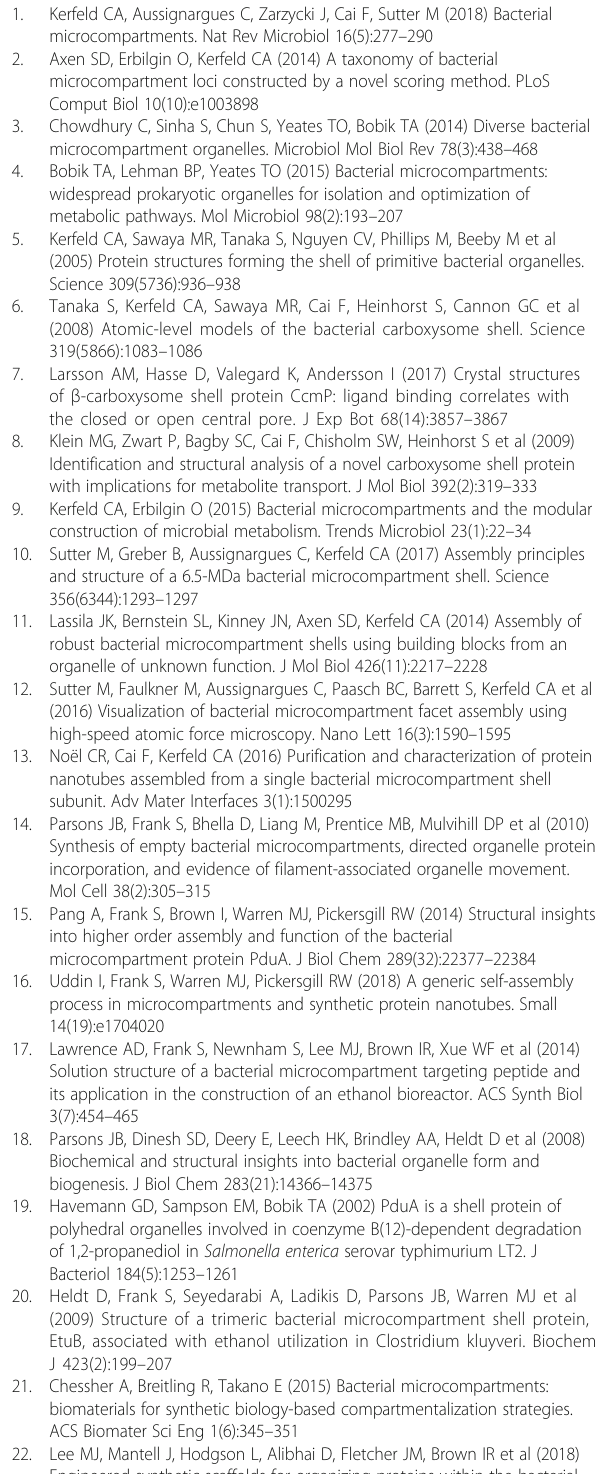
Additional file 1: Table S1. Mean patch sizes and rates of dynamic events under different environmental conditions. Table S2. Numbers of dynamic events (assembly and disassembly) of Hoch_5815 hexamers in shell sheets under HS-AFM. Figure S1. Schematic representation of sample preparation for AFM. Figure S2. AFM topographs of Hoch_5815 patches formed under different pH ranging from 3 to 10. Figure S3. Difference AFM images of Hoch_5815 captured under varying pH. Figure S4. AFM topographs of Hoch_5815 patches captured in buffers with varied concentrations of CaCl 2 , MgCl 2 , and KCl. Figure S5. Difference AFM images of Hoch_5815 captured under varying salt concentrations. (DOCX 1036